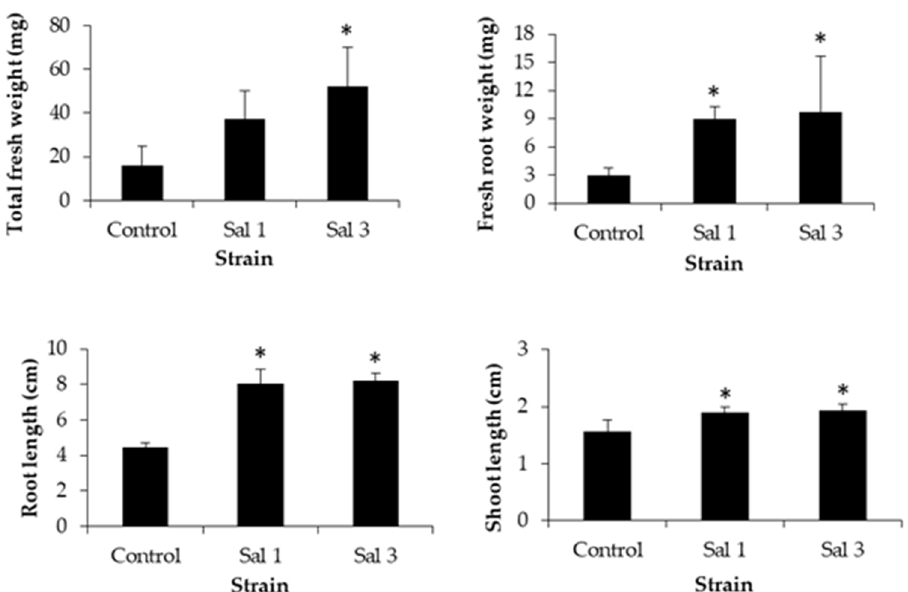
Figure 7. Effect of inoculation of sweet potato endophytes on the growth of tomato in non-limiting nitrogen conditions in Gelrite petri dishes. The bars represent standard deviation ( n = 3) and asterisks indicate a significant difference at P < 0.05 by Tukey’s test.